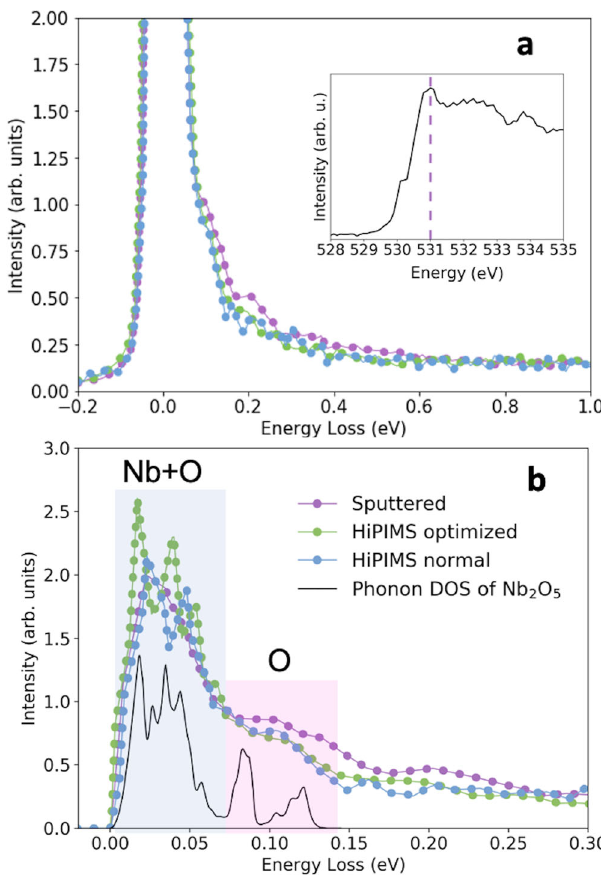
Fig. 4 Resonant inelastic X-ray scattering (RIXS) spectra measured for the Nb fi lms. a RIXS measurements at the oxygen K -edge resonance for an incident energy of 531 eV. The inset shows the O- K absorption spectrum of the sputtered fi lm with a vertical dashed line at the resonance. b Close-up view of the RIXS spectra after subtraction of the elastic line, with the phonon density of states (DOS) calculated for Nb 2 O 5 from 45 . The overall scaling factor of the DOS was chosen to aid visualization. The DOS was reported to arise from both niobium and oxygen up to ≈ 70 meV, and mostly from oxygen at higher energies, as represented by the blue and pink bands, respectively. The lower intensity at higher energies for the HiPIMS fi lms indicates a larger concentration of oxygen